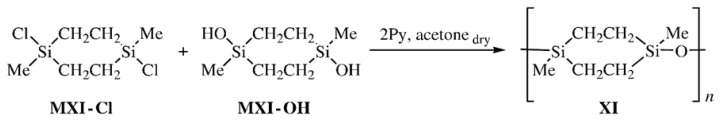
Synthesis of CL PMCS XI by heterofunctional condensation.